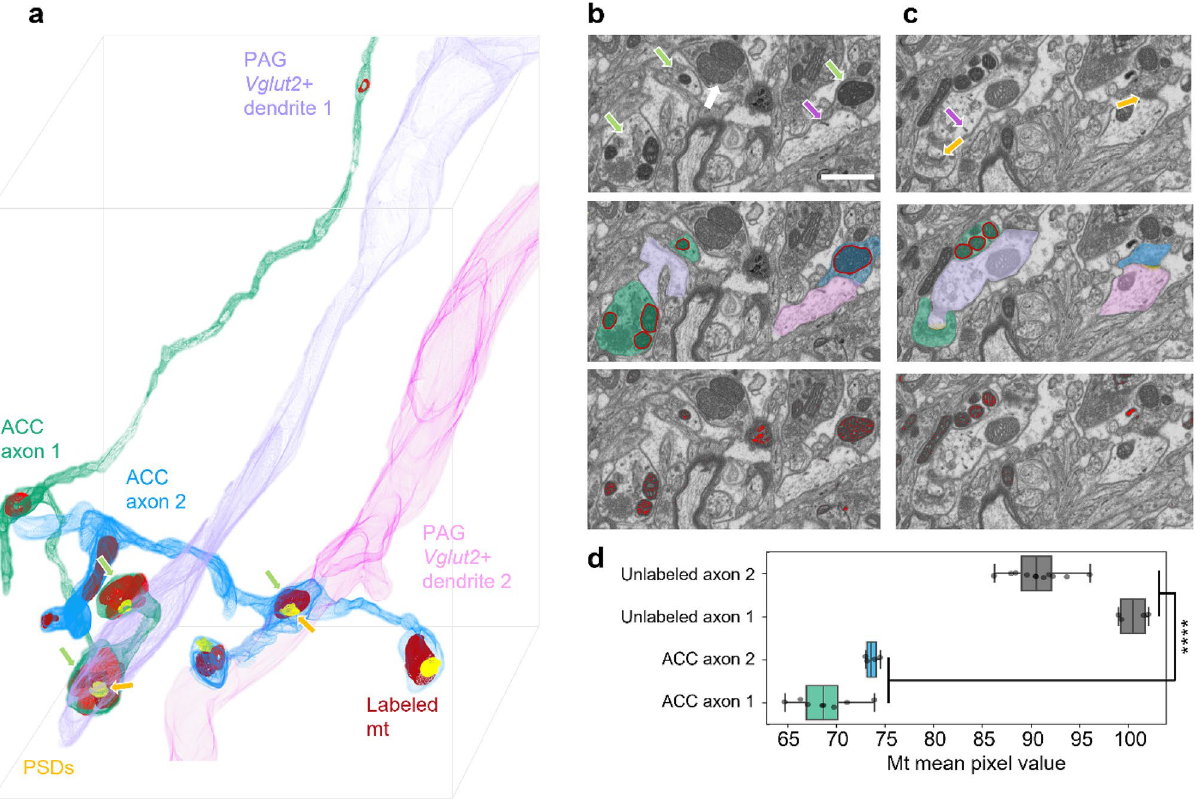
Figure 2. dAPEX2 labeled axons and dendrites can be reconstructed in 3D. ( a ) 3D reconstruction of two representative ACC axons (blue and green) containing several labeled mitochondria (mt). Both axons established exclusively asymmetric synapses with postsynaptic densities (PSDs). Two representative aspiny Vglut2 + target dendrites were reconstructed. ( b ) Representative planes showing dAPEX2 labeled ACC axons and dendrites. Top: labeled mitochondria and ER are indicated. Middle: segments are reconstructed. Bottom: binary mask highlights labeled mitochondria (scale bar is 1 µm for b,c ). ( c ) Same ROI at different depth showing asymmetric synapses with PSDs. ( d ) Mitochondria mean pixel value for labeled axons was significantly lower than for unlabeled axons (t-test, p-value = 3.55 × 10 –13 , sample 3; green arrow: labeled mitochondria; white arrow: unlabeled mitochondria; purple arrow: labeled ER; yellow arrow: